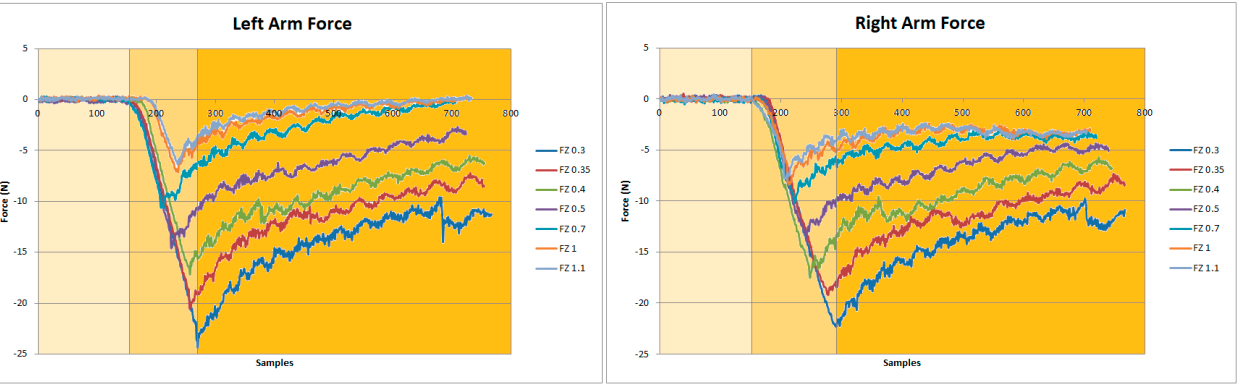
Figure 10. Forces needed to lift the box with different friction coefficients.